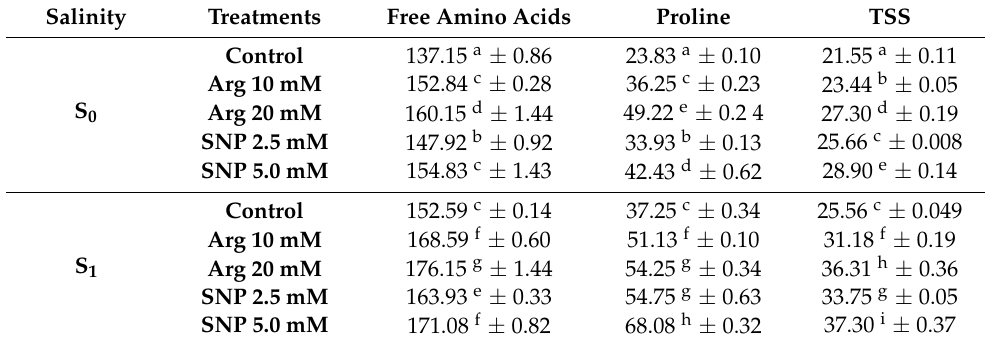
Table 2. Effect of arginine or SNP on free amino acids, proline ( µ g g − 1 fresh weight), and total